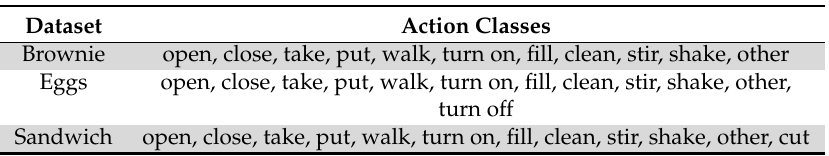
Table 4. Action classes for the three datasets.